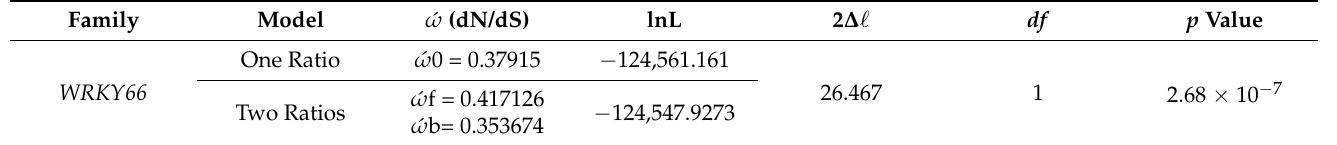
Table 3. Likelihood ratio tests were performed for the WRKY66 homologs. The WRKY66 lineage was designated as foreground